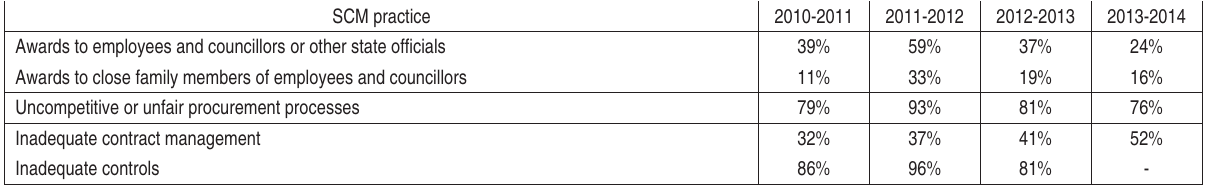
Table 3. State of SCM practices in municipalities of the case province SCM